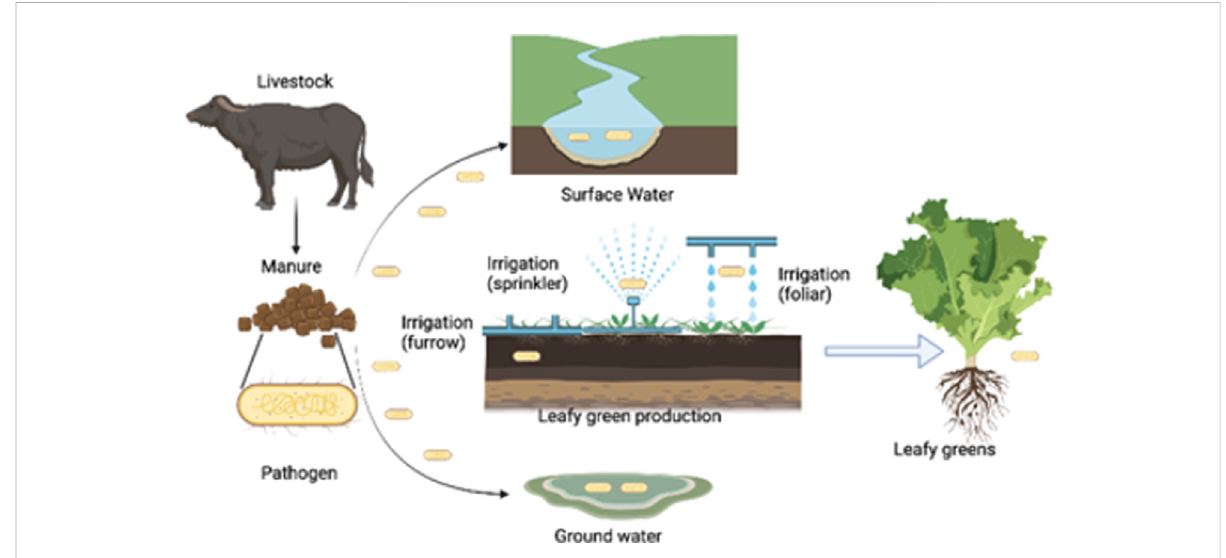
FIGURE 1 A potential route for the conveyance of pathogens in agriculture water systems via irrigation to the leafy green production environment. Plausible ways implicated leafy greens have become contaminated include runoff from these nearby lands, direct transmission from animal operations to romaine lettuce growing fi elds, and application of agricultural water contaminated with fecal material (California Department of Food and Agriculture.